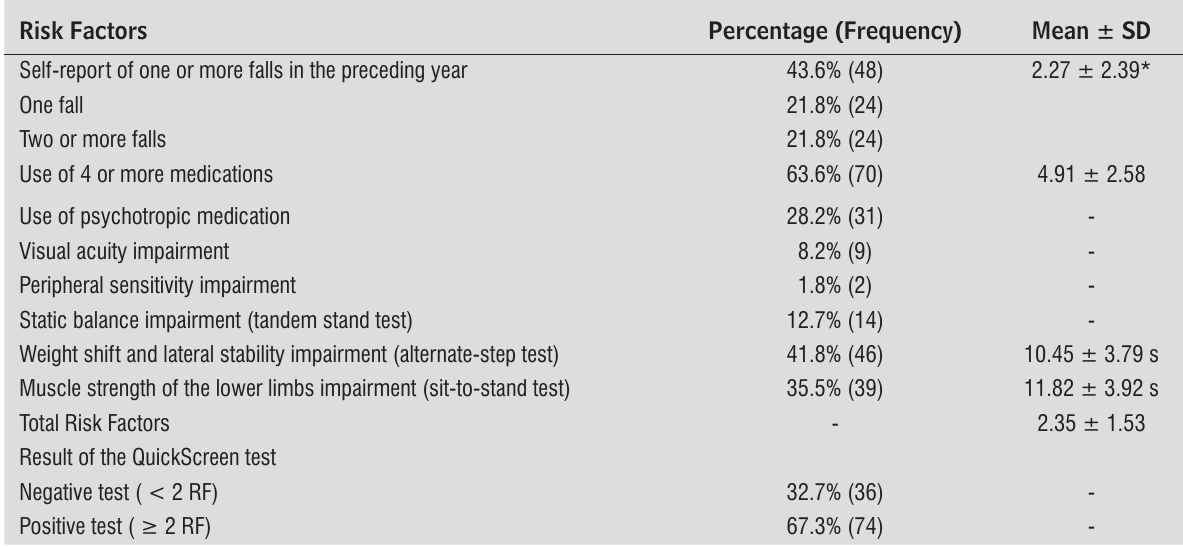
Table 2 - Description of the risk factors and the risk of falls evaluated in the QuickScreen Clinical Falls Risk Assessment test and the occurrence of falls in the sample over six months (n =